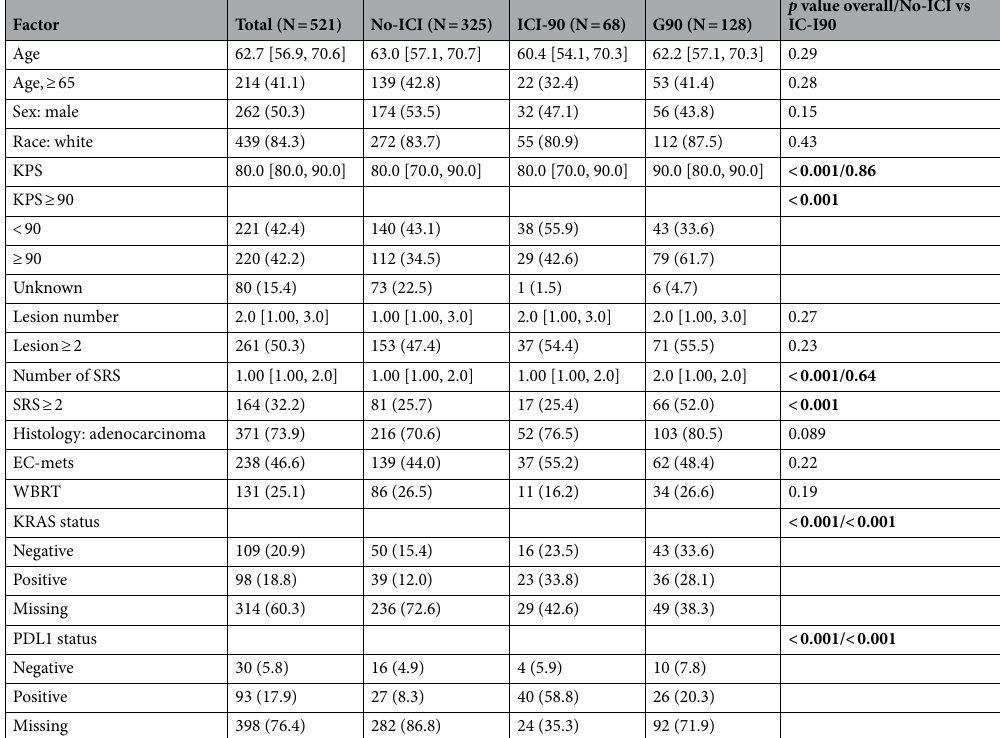
Table 1. Patient characteristics at diagnosis of brain metastasis. Data not available for all subjects. Missing values: KPS = 80, lesion number = 2, srs number = 12, Histology = 19, Extracranial Metastases = 10. Statistics presented as Median [P25, P75] or N (column %). Significant differences (p < 0.05) are